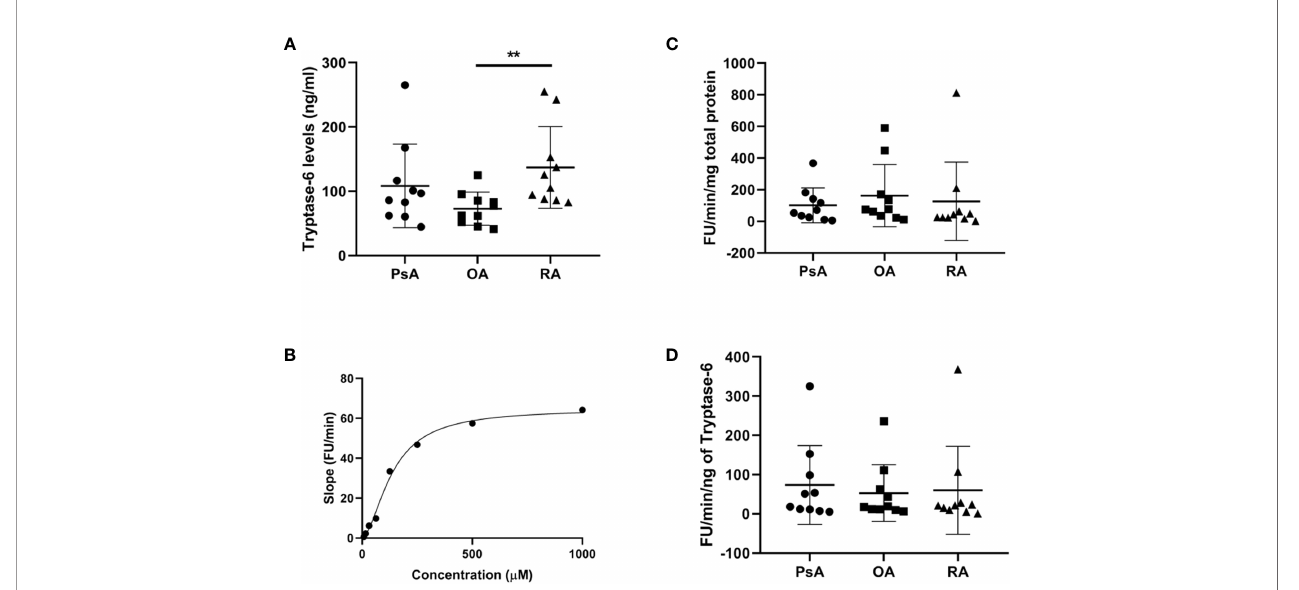
FIGURE 5 | Total and active tryptase-6 levels detected in SF from PsA, OA and RA patients. Total and active tryptase-6 levels were determined by a commercially available ELISA and a pull-down activity assay, respectively in PsA, OA and RA SF samples (n=10 per group). As shown in (A) , total levels of tryptase-6 were elevated in RA (median 115.6 ng/ml, range 87.6-175.5) compared to OA SF (median 70.08 ng/ml, range 50.3 – 87.9, p=0.002, Mann Whitney U test). The activity of pulled down-tryptase-6 from PsA SF towards VPR-AMC generated the substrate cleavage curve shown in (B) . Tryptase-6 activity from SF samples, after normalization to either total protein levels (C) or total tryptase-6 (D) , did not reveal any signi fi cant differences between groups. Asterisks are used to indicate signi fi cant differences between groups, where